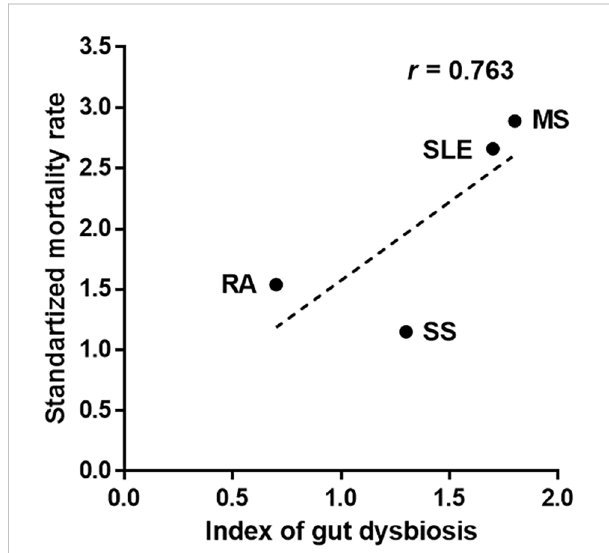
FIGURE 1 Association between the number of altered gut bacteria and mortality in patients with autoimmune diseases. The index of gut dysbiosis is de fi ned as the number of altered gut bacterial taxa divided by the number of studies. R is Pearson ’ s correlation coef fi